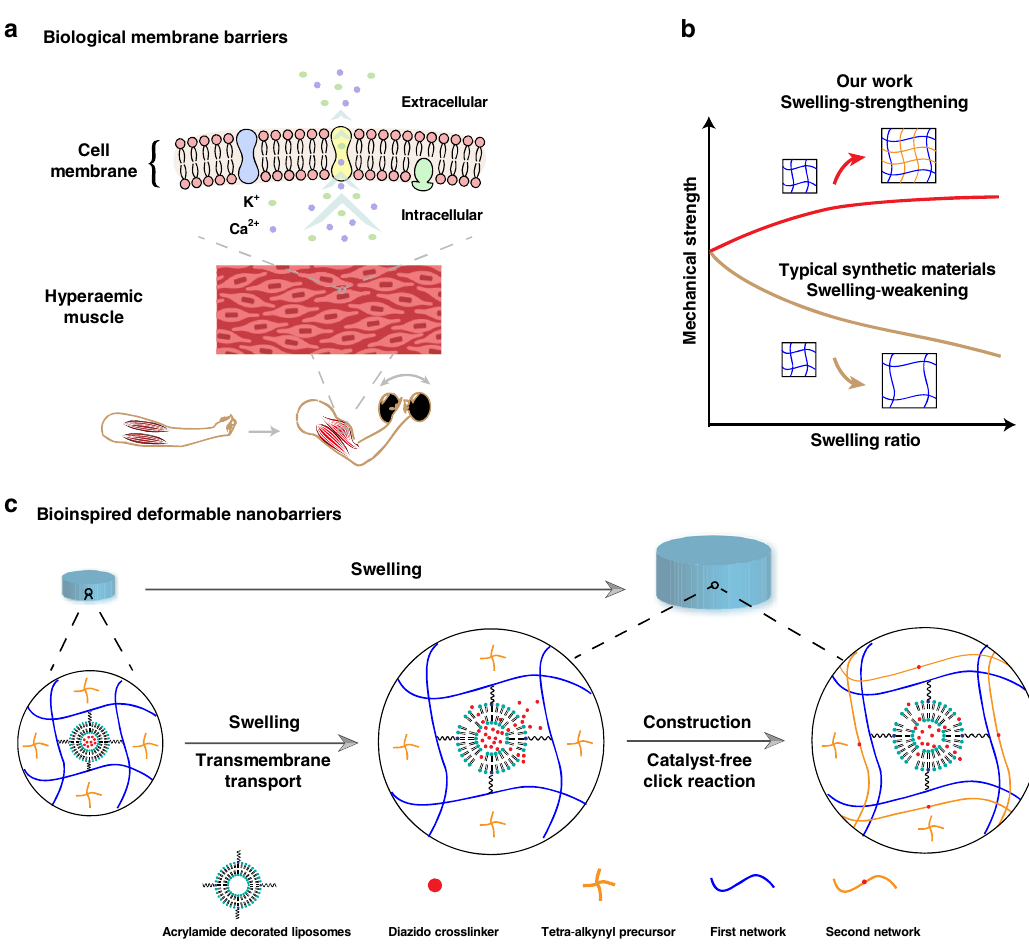
Fig. 1 Schematic illustration of the swelling-strengthening behavior. a Biological membrane barriers existed in living tissues, such as muscle. Transmembrane transport that is responsible for the hyperemia-mediated increasement of muscle stiffness depends on the ionic channel, transporters, diffusion, etc. b Variation of mechanical strength after swelling between typical synthetic materials and the swelling-strengthening hydrogels (SSHs) described in this work. c Development of SSHs via a biological membrane barrier-inspired strategy. Transport across the synthetic liposomal membranes mainly relies on